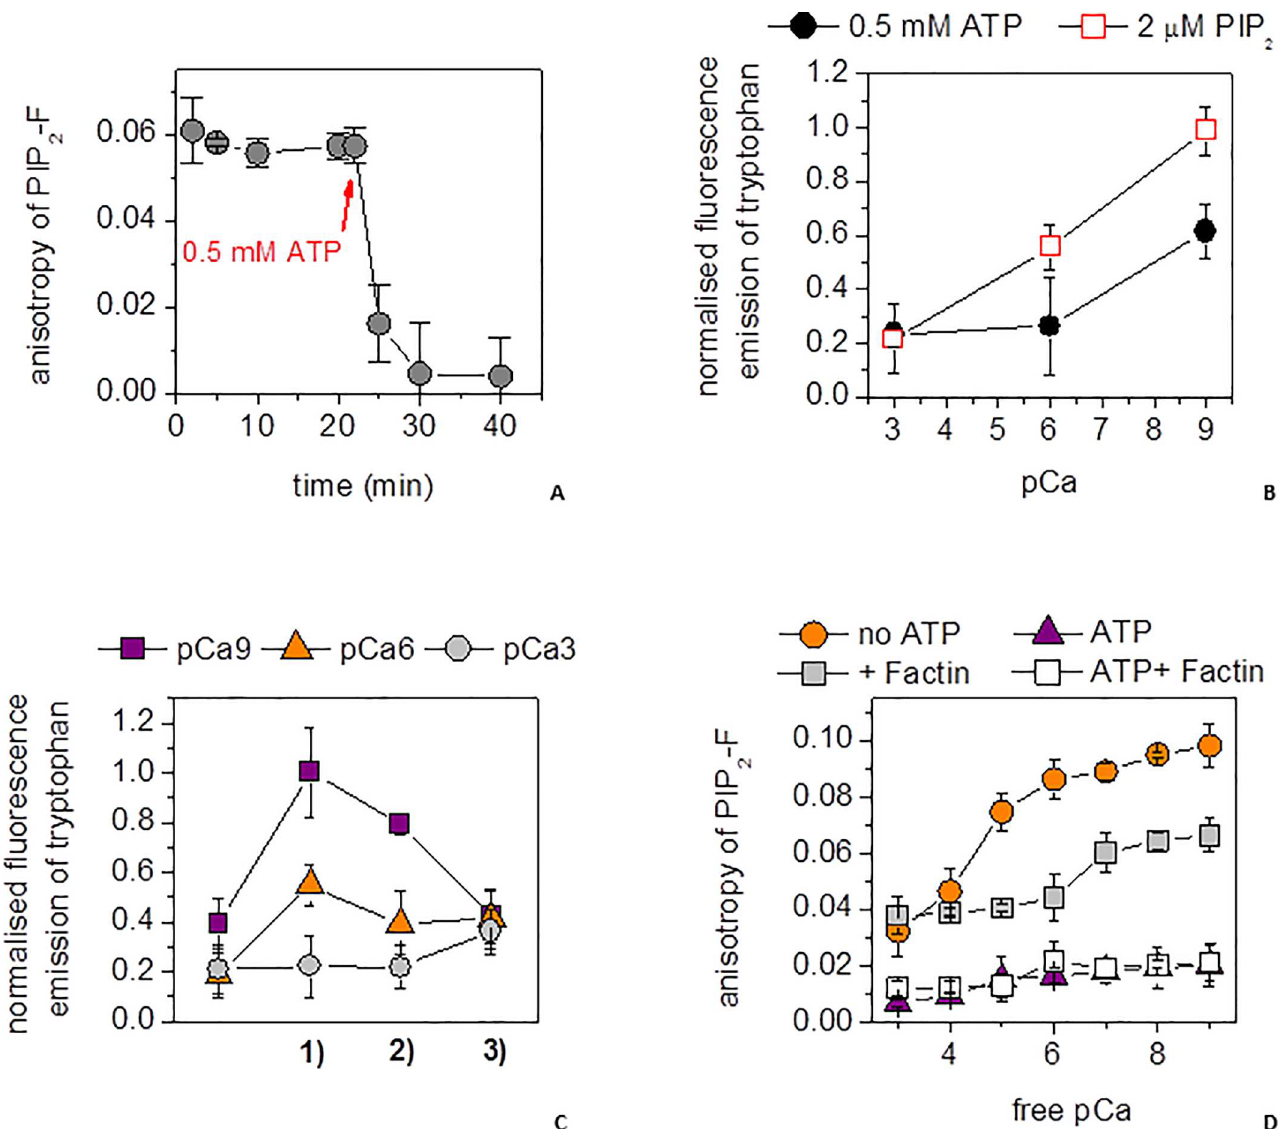
Fig 2. PIP 2 binding to gelsolin under actin polymerizing conditions. (a) The anisotropy of PIP 2 -F (0.25 μ M) was measured as a function of time in the presence of 5 μM gelsolin, 10 μM Ca 2+ (pCa 5), 1 mM Mg 2+ (pMg 3) and 50 mM K + (gray circles). After 20 min, ATP (0.5 mM) was added. (b) Tryptophan fluorescence emission of gelsolin (5 μM) was measured at steady-state at three free-calcium concentrations: 1 nM (pCa 9), 1 μM (pCa 6) and 1 mM (pCa 3) in the presence of 2 μM PIP 2 (red open squares) or 0.5 mM ATP (filled black circles). (c) Tryptophan fluorescence emission of gelsolin (5 μM) was measured at steady- state at three free-calcium concentrations: 1 nM (pCa 9, purple squares), 1 μM (pCa 6, orange triangles) and 1 mM (pCa 3, gray circles) through a cycle of 1) 2 μM PIP 2 addition, 2) 0.5 mM ATP addition and 3) calcium levels set to 1 μM (pCa 6). (d) The steady-state anisotropy of PIP 2 -F (0.25 μM) in the presence of gelsolin (5 μM) under actin polymerizing salt conditions (1 mM Mg 2+ (pMg 3), 100 mM K + , orange circles) followed a similar profile to that without salt across a wide range of calcium ion concentrations (see data presented on Fig 1 D ). Addition of F-actin (50 μM, gray squares) reduced the anisotropy, but still indicated significant binding. Inclusion of ATP (0.5 mM) reduced the anisotropy close to background levels, to the value characteristic to free PIP 2 -F both in the presence (white squares) and absence (purple triangles) of F-actin (50 μM) indicating the dissociation of the gelsolin/PIP 2 -F complex across the entire calcium concentration